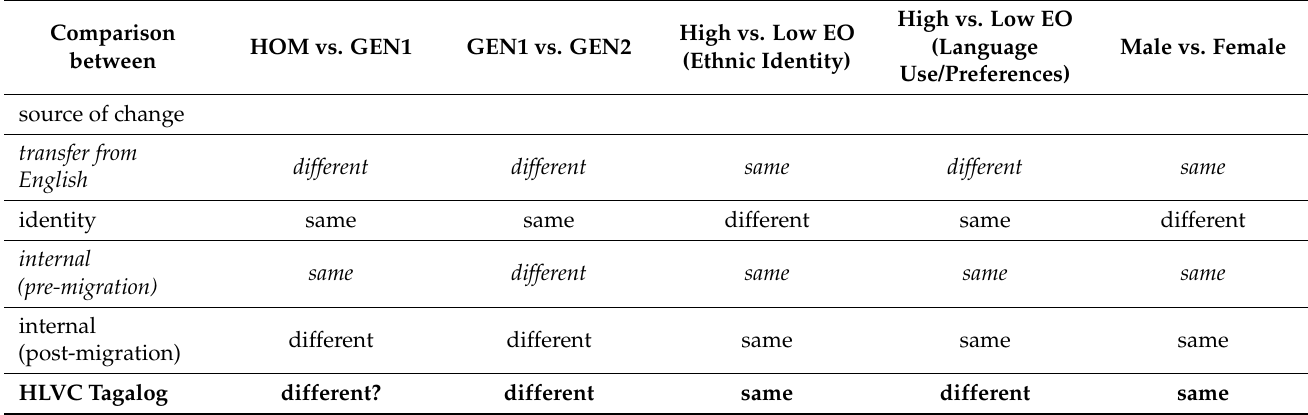
Table 12. Profiles of each source of variation and change, according to patterns of inter-group differences showing that Tagalog approximant variation is best matched to transfer from English and internal change (post-migration). Comparison HOM vs. GEN1 GEN1 vs. GEN2 between